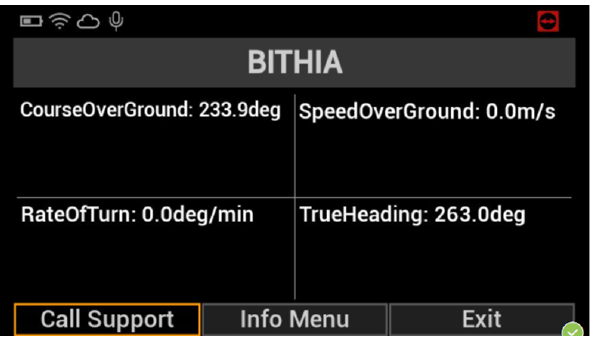
Figure 7. Real-time information shown by the smart